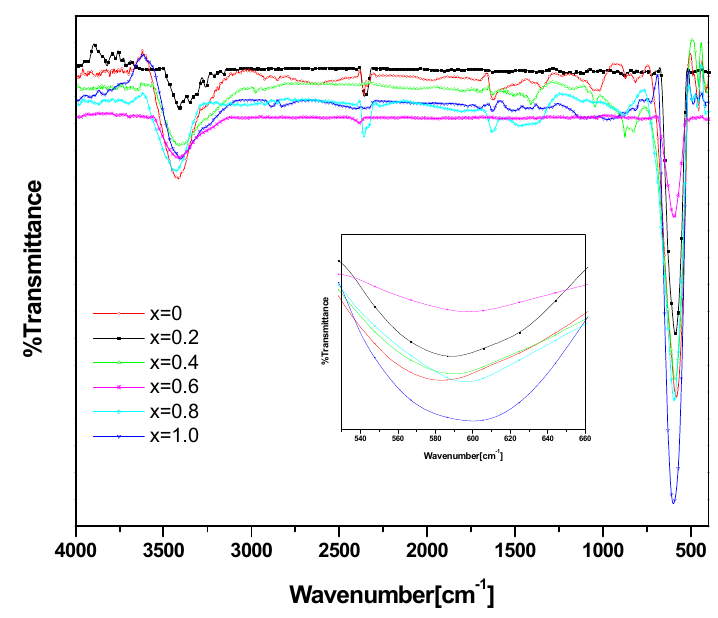
Fig. 3 FTIR Spectra of the specimens at different dompositions.